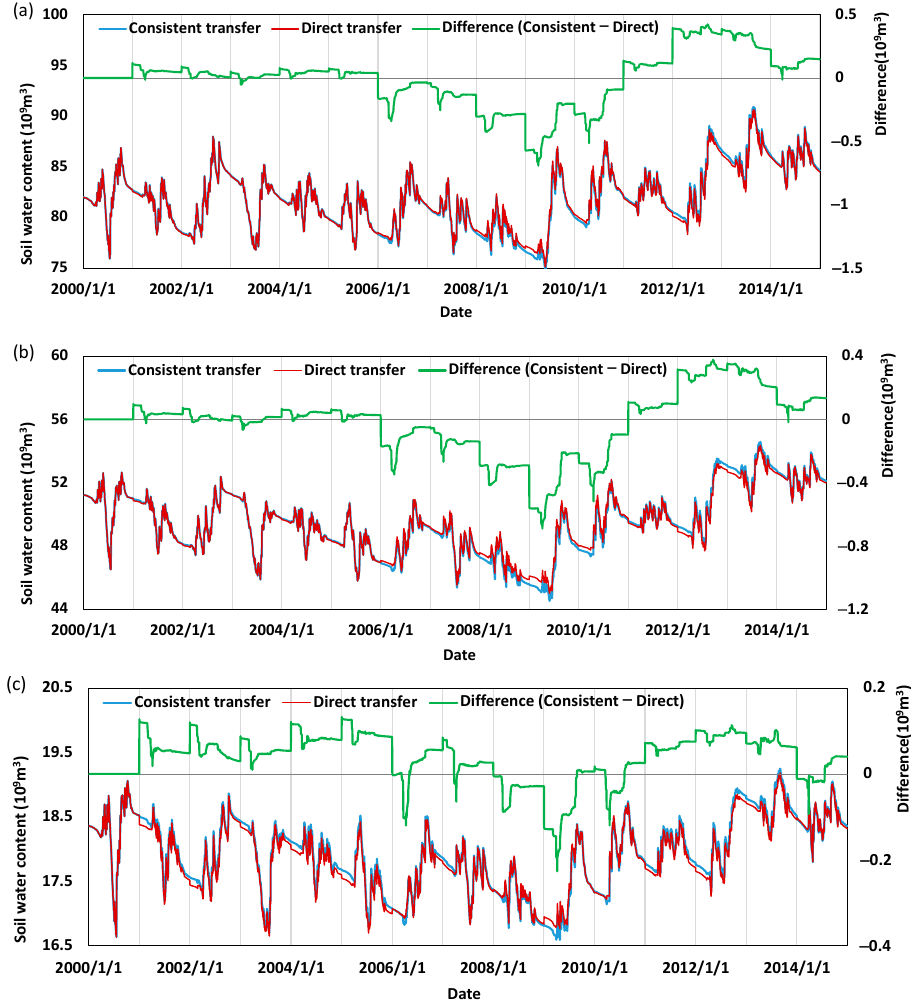
Figure 13. Daily process comparison of the total soil water content under consistent and direct transfer of HRU water storage using MODCYCLE in ( a ) the whole Sanjiang Plain, ( b ) the plain areas, and ( c ) the sub-watersheds with paddy field relative difference in land use (LUD R ) greater than 0.17 (Figure 9b). The soil water content simulated by the model is within 3 m below the ground surface. Difference (consistent–direct) means the difference in soil water content under the consistent transfer and the direct transfer.